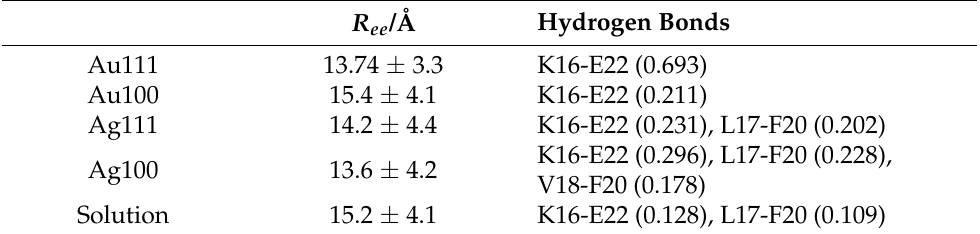
Table 2. Average end-to-end lengths and common hydrogen bonds. Numbers in parentheses give probabilities of each hydrogen